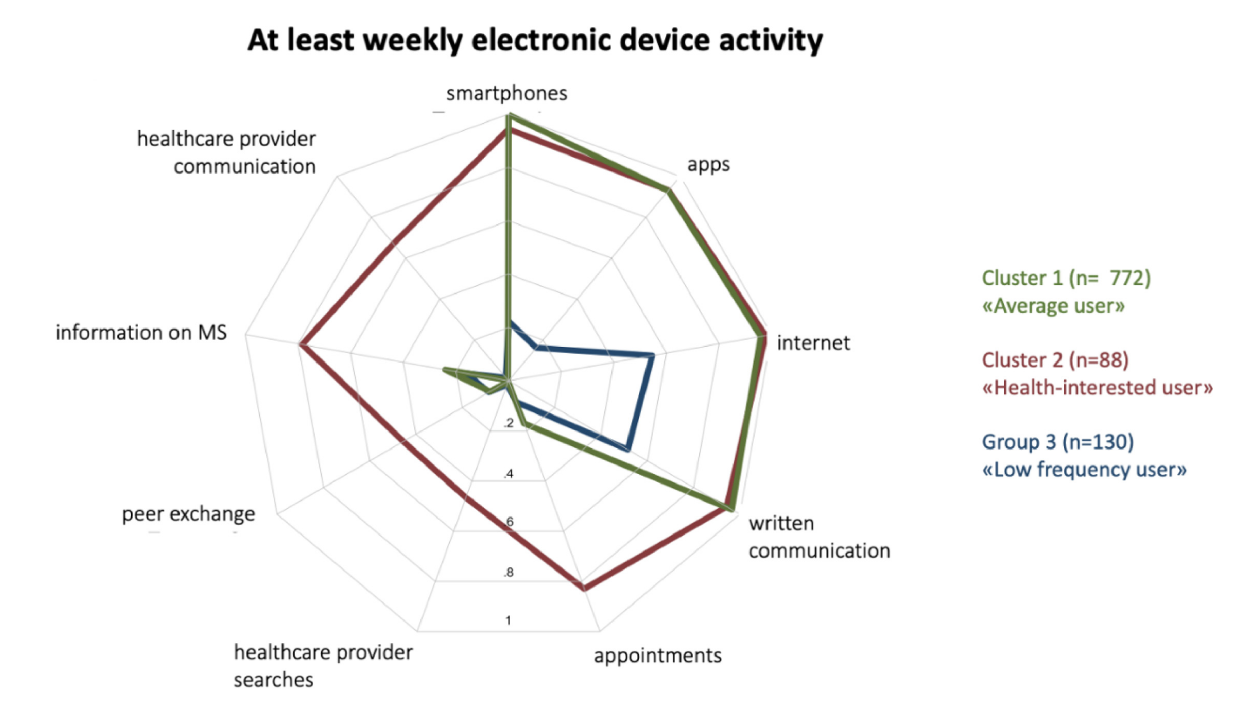
Fig 2. Radar plot of the three groups derived from the final factor analysis. Each grey plot line corresponds to a proportion, with the center marking 0% and the outermost line 100%. The colored lines indicate the proportion of respondents in each cluster that report at least weekly use of internet-connected devices and associated health and non-health-related